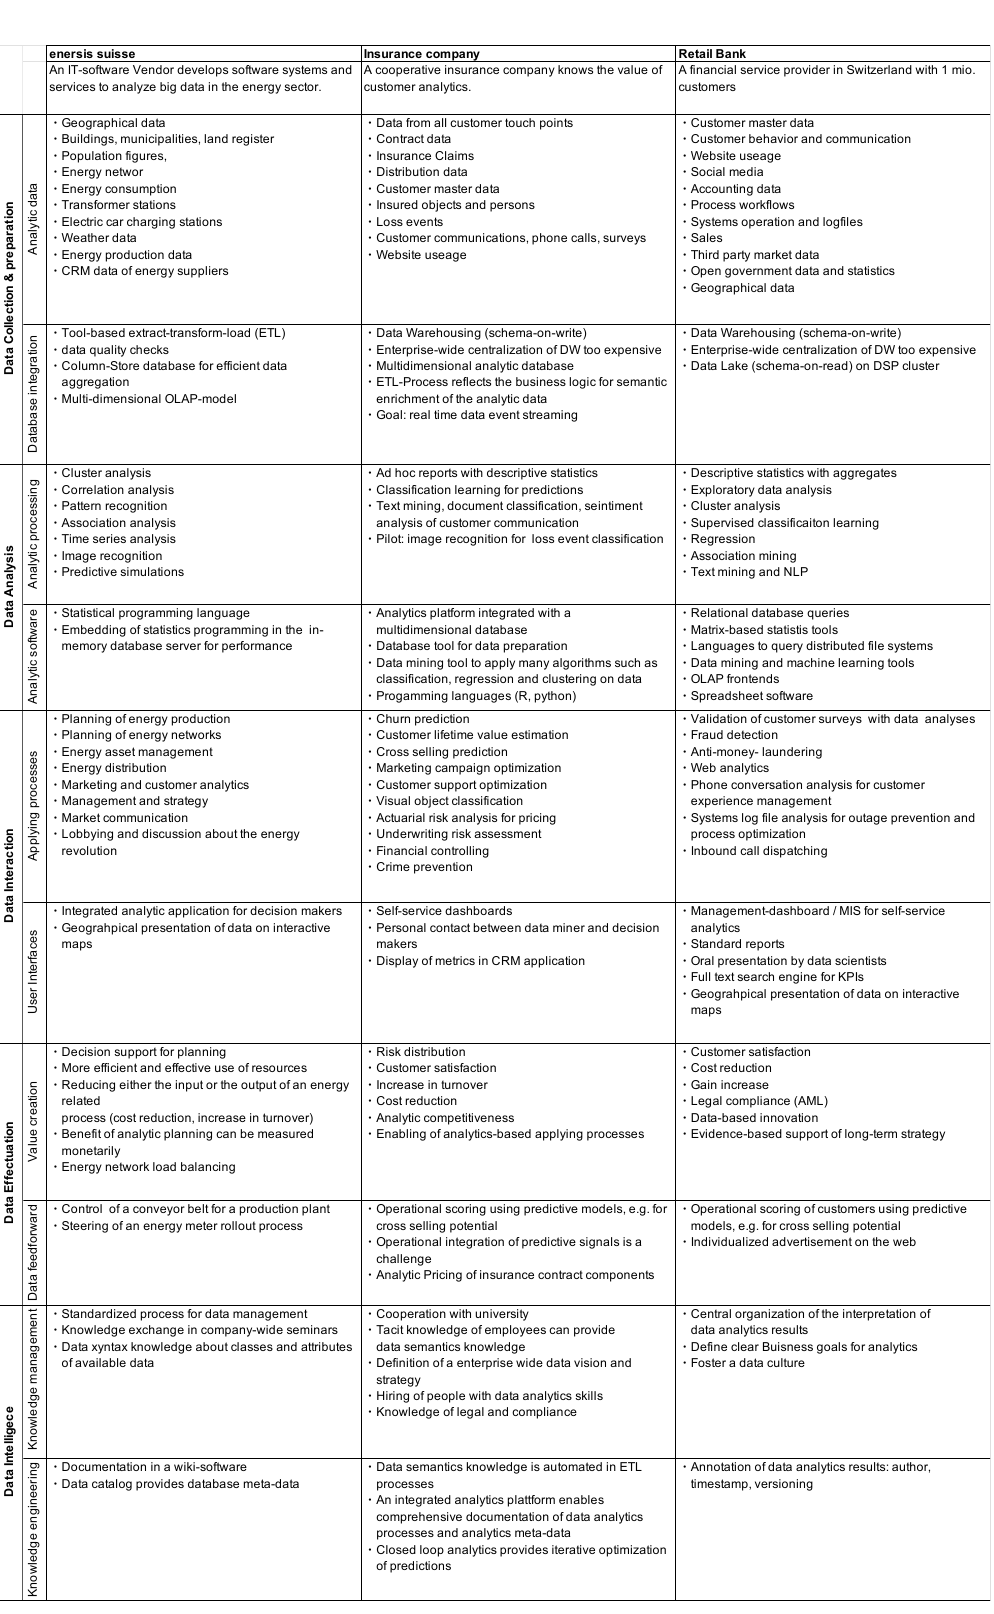
Figure 5. Summary of the case studies with mapping to the reference